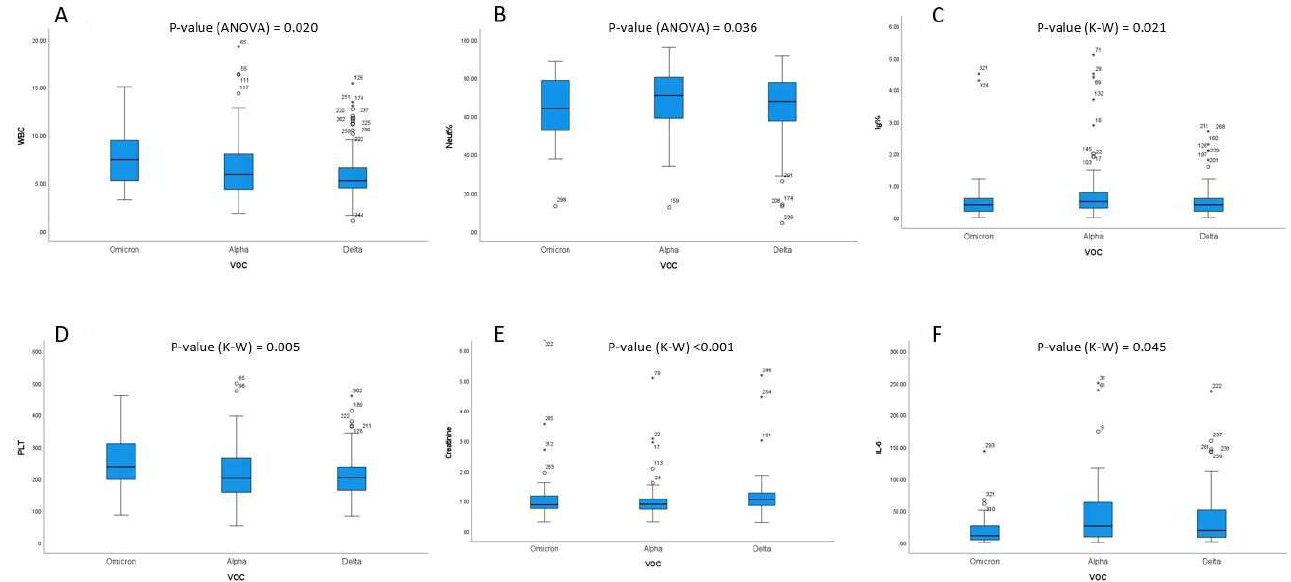
Figure 1. Blood count and biomarker differences among patients affected with Alpha, Delta and Omicron. ( A ) Differences in white blood cell count among the different VOC subtypes. ( B ) Differences in % of neutrophils among the different VOC subtypes. ( C ) Differences in % of immature granulocytes among the different VOC subtypes. ( D ) Differences in platelet count among the different VOC subtypes. ( E ) Differences in creatinine levels among the different VOC subtypes. ( F ) Differences in IL-6 levels among the different VOC subtypes. Stars represent extreme outliers.